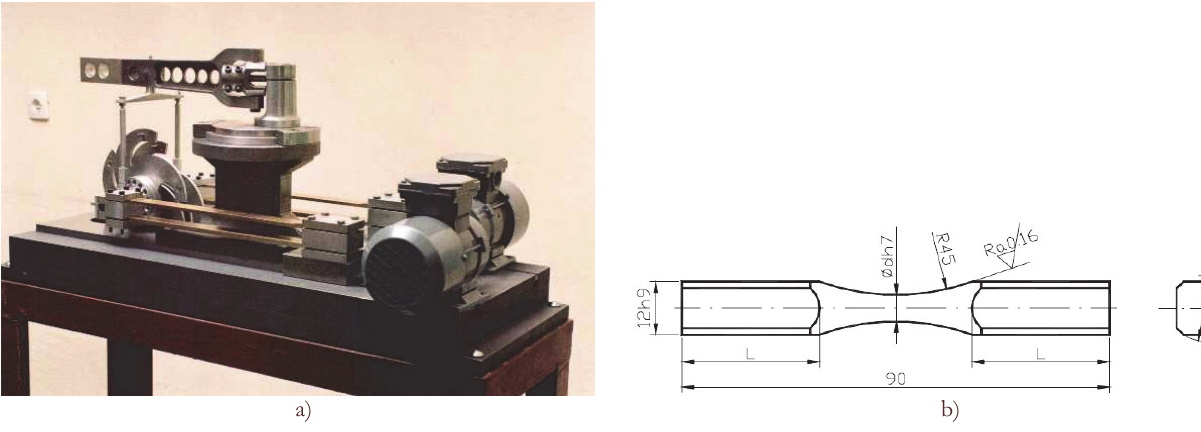
Figure 2: Test stand MZGS-100 (a) and specimen of fatigue strength test